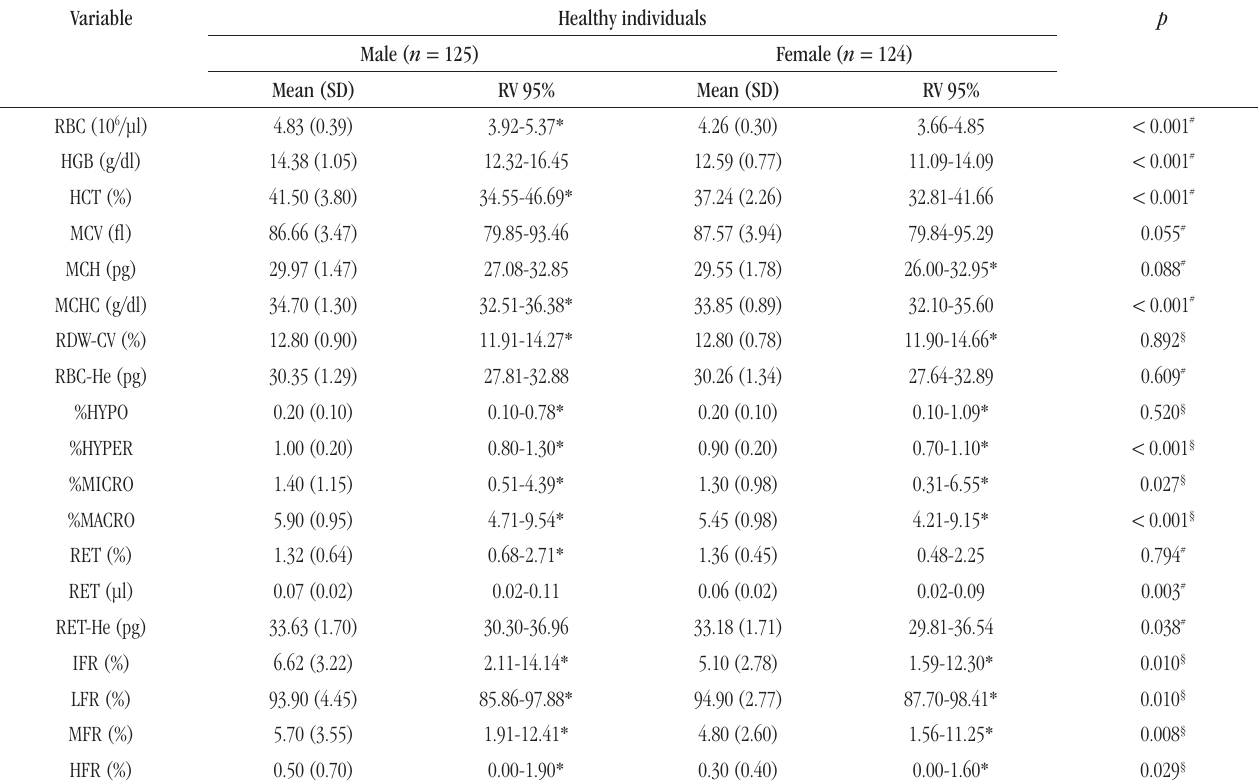
taBLE 1 − Evaluation of traditional and extended erythrocyte parameters and reticulocyte indices of healthy individuals ( n = 249)